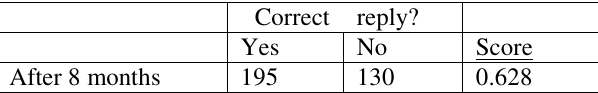
Table 2. The results of the same experiment as in Table 1 carried out 8 months later.